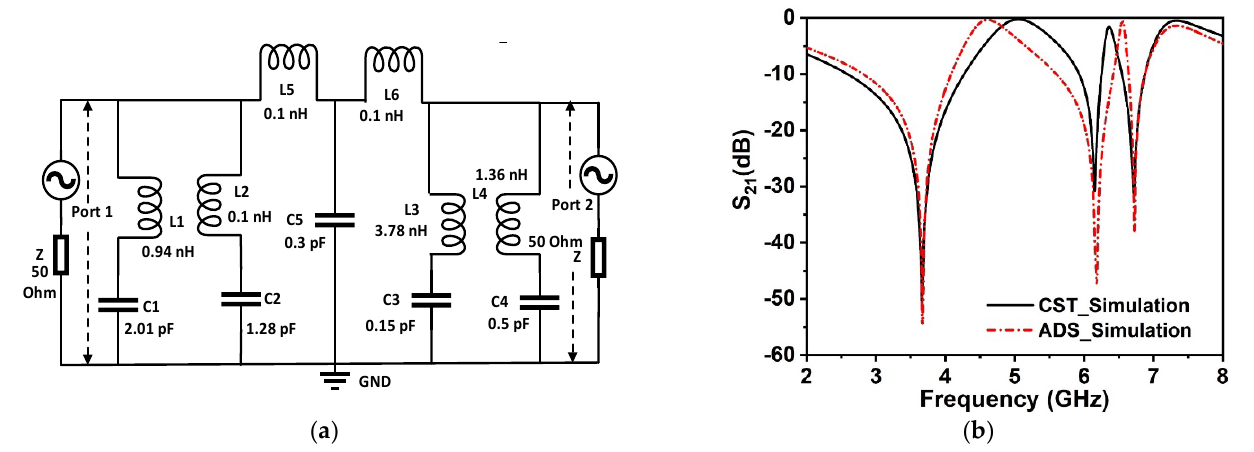
Figure 5. ( a ) Equivalent circuit of the proposed MM unit cell. ( b ) Transmission coefficient ( S 21 ) comparison for CST and ADS simulations.